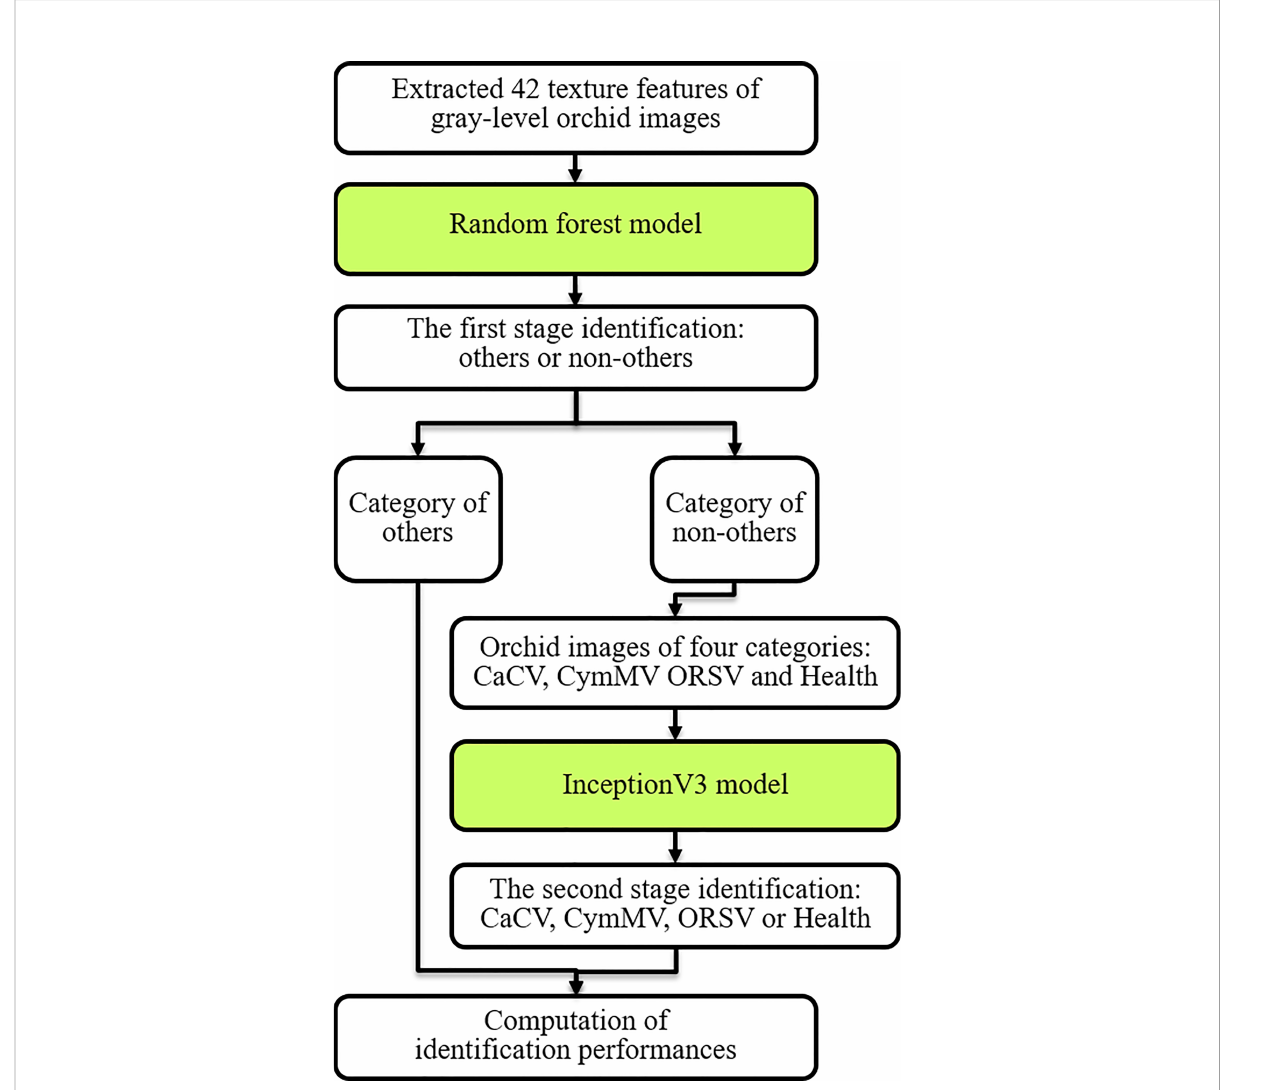
FIGURE 10 Procedures of the two-stage identi fi cation model for identifying orchid diseases using extracted leaf features and orchid